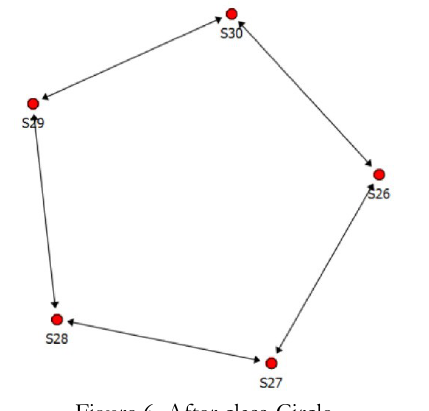
Figure 6. After class-Circle Figure 7. After class-All